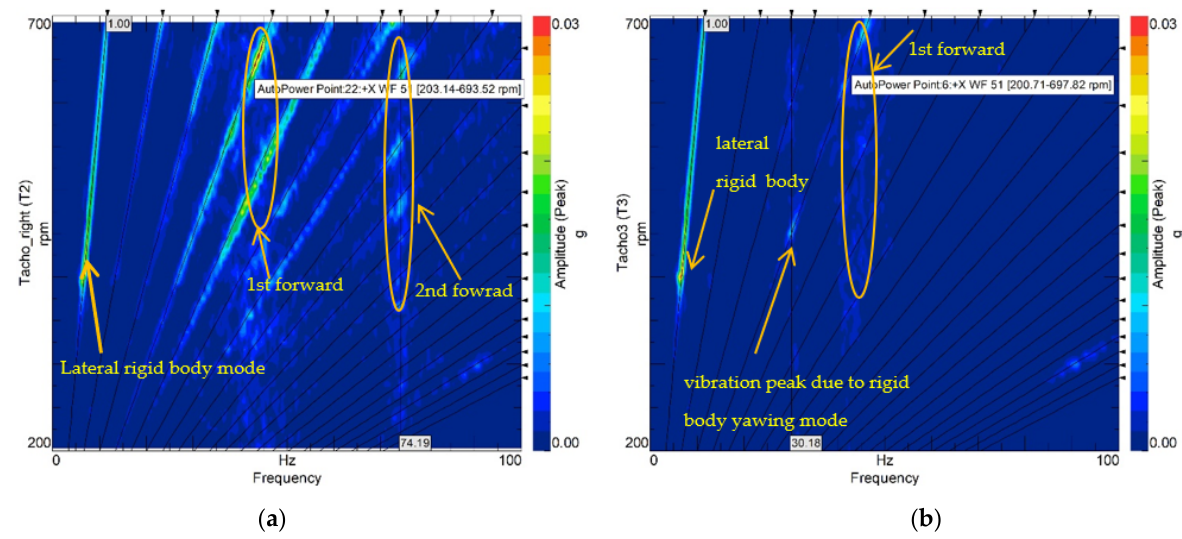
Figure 7. Test-b preliminary results, auto-power recorded at sensor MP22 horizontal ( a ), sensor MP6 horizontal ( b ). The resonances at 7 Hz, 30 Hz and 74 Hz corresponds to the lateral rigid body movement of the machine pedestal, rigid body yawing mode of the machine pedestal and 2nd forward whirling mode of the rotor, respectively.